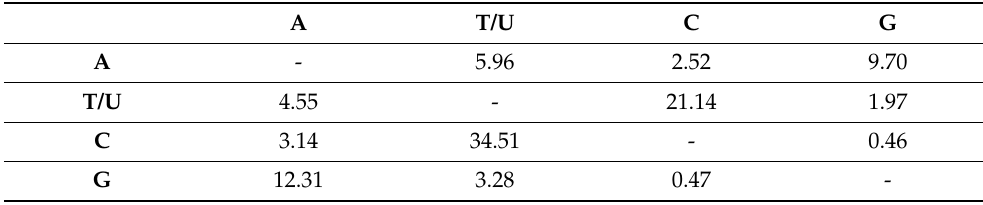
Figure 2. Vegetative features of T. antarcticum in histological sections ( A – B ) and under SEM ( C – F ), showing cells in the ventral thallus curving upwards ( A – D ), Surface layer (epithallus) ( E – F ) and close up of the cell wall structure showing early needle crystals running parallel to the cell wall and later formed crystal running perpendicular to the cell wall ( F ). Scale bars = 100 µm ( A – D ), 20 µm ( E – F ). Table 1. Maximum Likelihood Estimate of Substitution